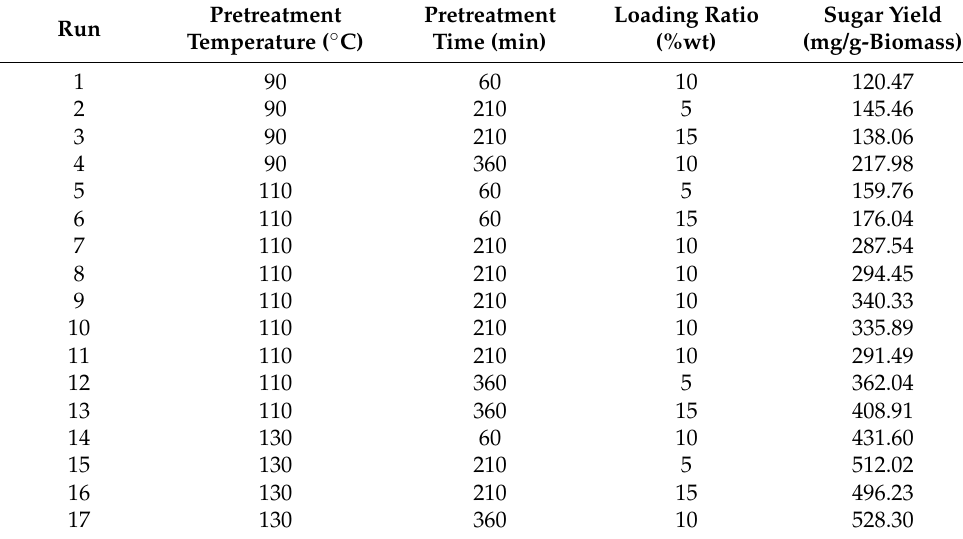
Table 1. [Ch][OAc] pretreatment conditions on rice straw based on RSM with Box-Behnken design. The reducing sugar yield (Y) was measured after pretreatment of each condition with different temperature (X 1 ), time (X 2 ), and loading ratio (X 3